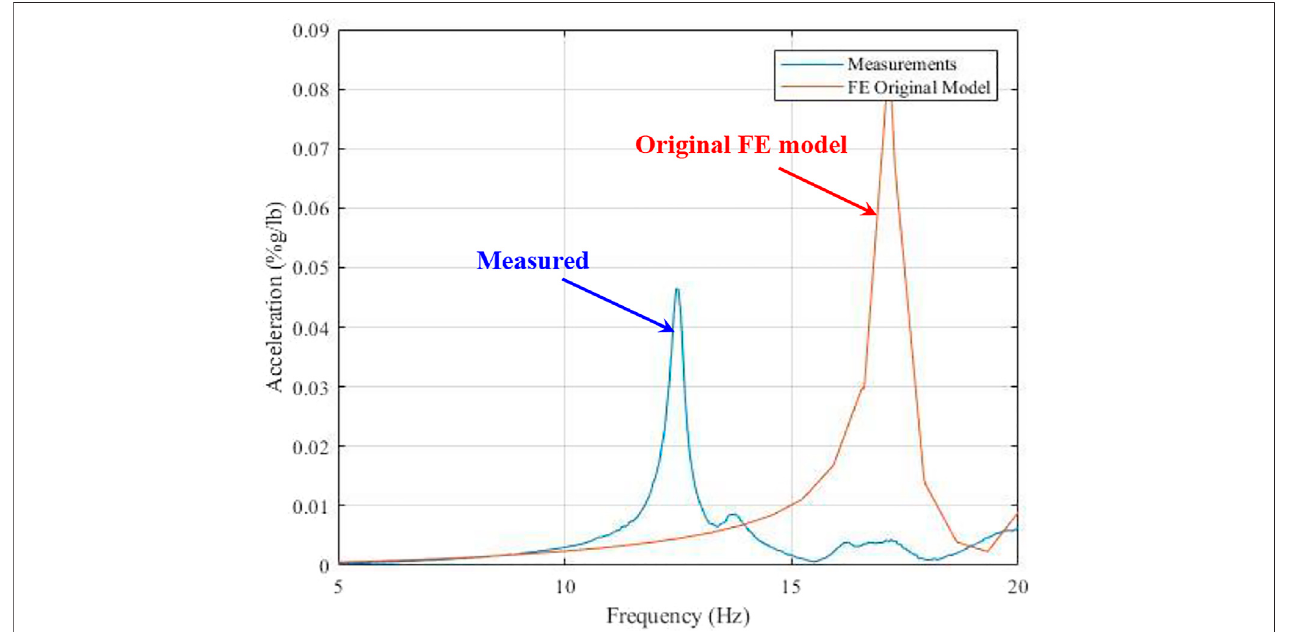
FIGURE 8 | Measured and FE model predicted FRF magnitudes at the driving point (Location 12) (bare slab con fi guration).